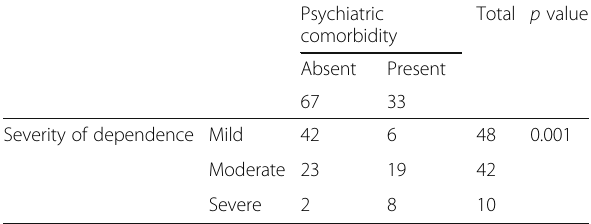
Table 6 Comparison of patients with and without psychiatric comorbidity in relation with the severity of alcohol